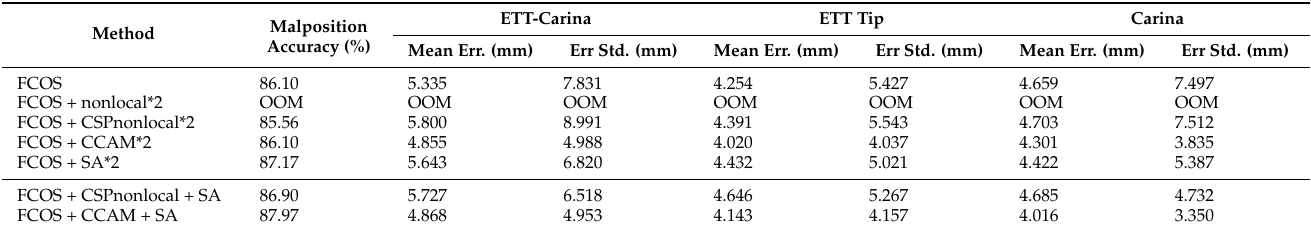
Table 20. The effect of fusing global modelling attention and scale